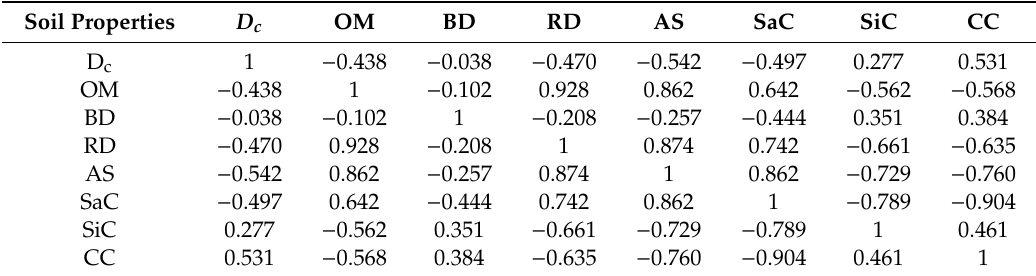
Table 3. Pearson’s correlation matrix among the soil properties for the four land uses (cropland, grassland, woodland and forestland, n = 25 for each land use) of the Saravan watershed (Northern Iran). Soil Properties D c OM BD RD AS SaC SiC CC D c 1 − 0.438 − 0.038 − 0.470 − 0.542 − 0.497 0.277 0.531 OM − 0.438 RD − 0.470 0.928 − 0.208 0.874 0.742 − 0.661 − 0.635 AS − 0.542 0.862 − 0.257 SiC 0.277 − 0.562 0.351 − 0.661 − 0.729 − 0.789 1 0.461 CC 0.531 − 0.568 0.384 − 0.635 − 0.760 − 0.904 0.461 1